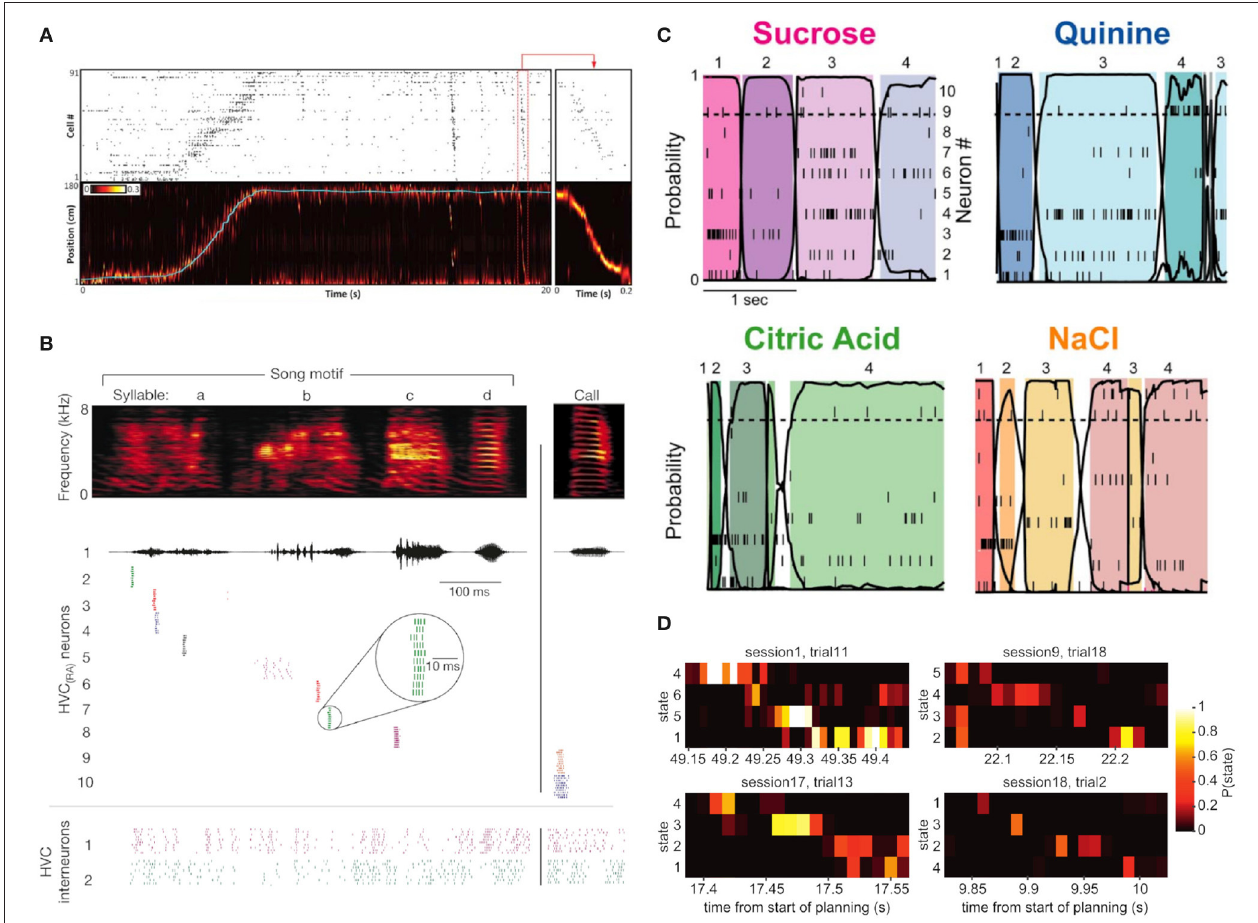
FIGURE 1 | Four illustrative examples of sequential neuronal activity in different paradigms and experimental contexts. (A) Sequential activation of rat hippocampal cells are found during action and in rest phases after the behavioral tasks. The top plot shows the spiking histogram of 91 hippocampal cells during a rat’s trip along a physical track. The bottom panel shows the rat’s actual position on the track (blue line) against the position inferred from the spiking pattern of its hippocampal cells. After the traversal of the track, hippocampal cells “replayed” their activation sequence in reverse during a short ripple event (red box, enlarged in the box on the right). Figure adapted from Pfeiffer (2020) (Copyright 1999–2019 John Wiley & Sons, Inc.). (B) Zebra finches are songbirds whose songs consist of highly consistent so-called song motifs. Here, the activations of ten different HVC (RA) neurons and two HVC interneurons in the HVC nucleus of the zebra finch brain during ten renditions of the same song motif are shown. HVC (RA) project from the HVC nucleus to the RA nucleus in the birdbrain, and exhibit precise and reproducible firing sequences during the rendition of a song. Adapted from Hahnloser et al. Hahnloser et al. (2002) with permission from Springer Nature. (C) Firing patterns of neurons in the gustatory cortex of rats in vivo when presented with four different odors. The sequential switching of states of a hidden Markov model (HMM, see section 3.1) was characteristic of the presented aroma. For each of the four odors, the different color hues represent different HMM states that were inferred based on the data. Adapted from Jones et al. (2007) (Copyright 2007 National Academy of Sciences, U.S.A.). (D) Evidence for fast sequence representation in human participants during planning of a trajectory through task state space, see Kurth-Nelson et al. (2016) for details. The four examples, each for a different participant, show evidence of brain activity, as measured with magnetoencephalography (MEG), to quickly transition through task state space with roughly 40 ms duration for each sequence element. Figure taken from Kurth-Nelson et al.